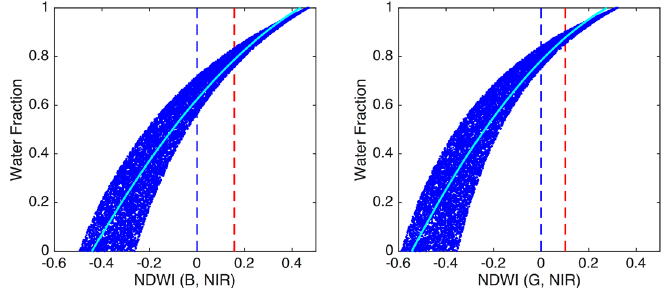
Figure 10. The regressions of NDWI values with different band combinations obtained from synthetic GeoEye spectra against known water fractions; the pair of bands used for the calculation of NDWI is indicated on each graph; zero-threshold and Otsu’s threshold are illustrated, respectively, with blue (dashed) and red (dot-dashed) lines.